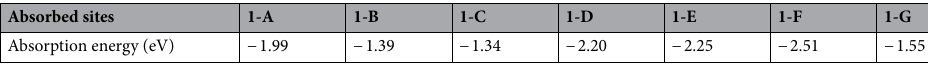
Table 2. The adsorption energy of 2 Si’ atoms on ASiNRs:H surface.